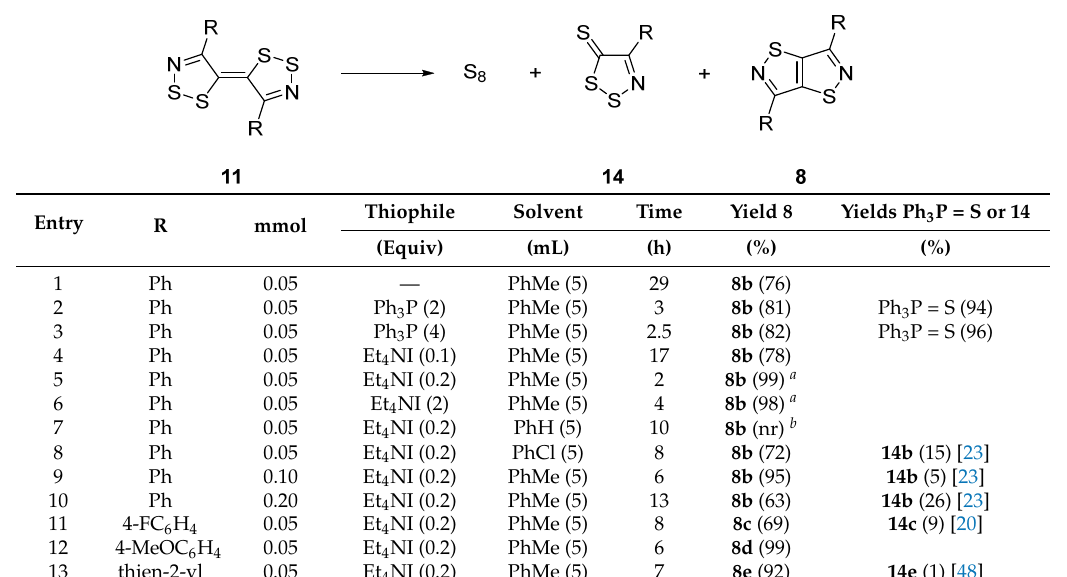
Table 2. Optimization of the ring transformation of ( E ) ‐ 4,4 ′‐ diphenyl ‐ 5,5 ′‐ bi(1,2,3 ‐ dithiazolylidene) 11b